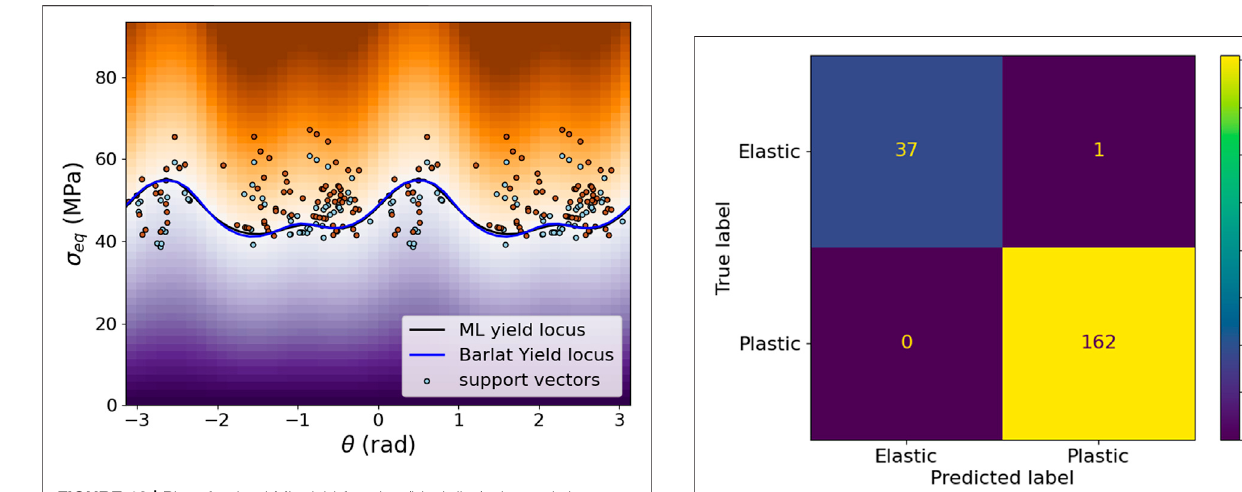
FIGURE 16 | Plot of trained ML yield function (black line), the analytic Barlat yield function (blue line) and the support vectors (circles) in cylindrical coordinates on the π -plane. The same color scheme as in Figure 5 has been applied.